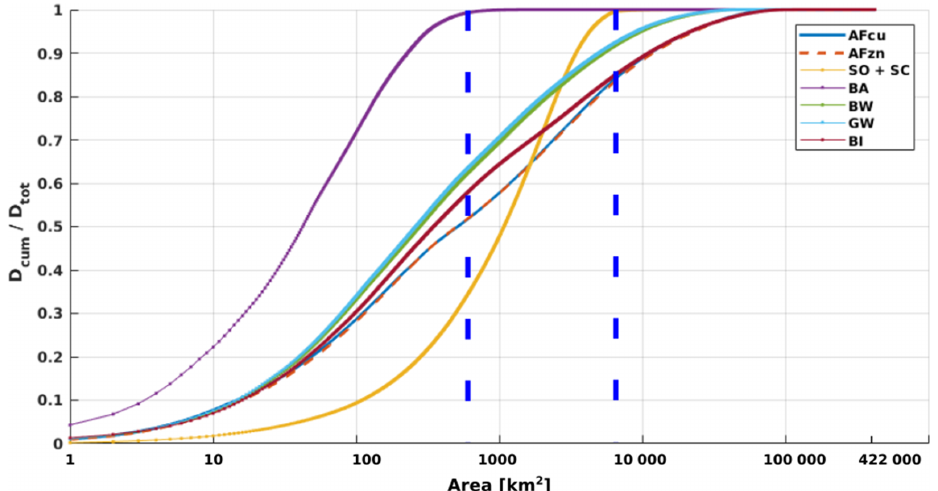
Figure 12. The cumulative discharges over the area of the Baltic Sea divided by the total discharges for the year 2012. Vertical blue dashed lines correspond to the areas of total load of the ballast water and scrubber water discharges. AFCu: antifouling paint release CuO; AFzn: antifouling paint release ZnO; SO + SC: scrubber effluent release both from open- and closed-loop systems; BA: ballast water discharge; BW: sewage release; GW: grey water discharge; BI: bilge water